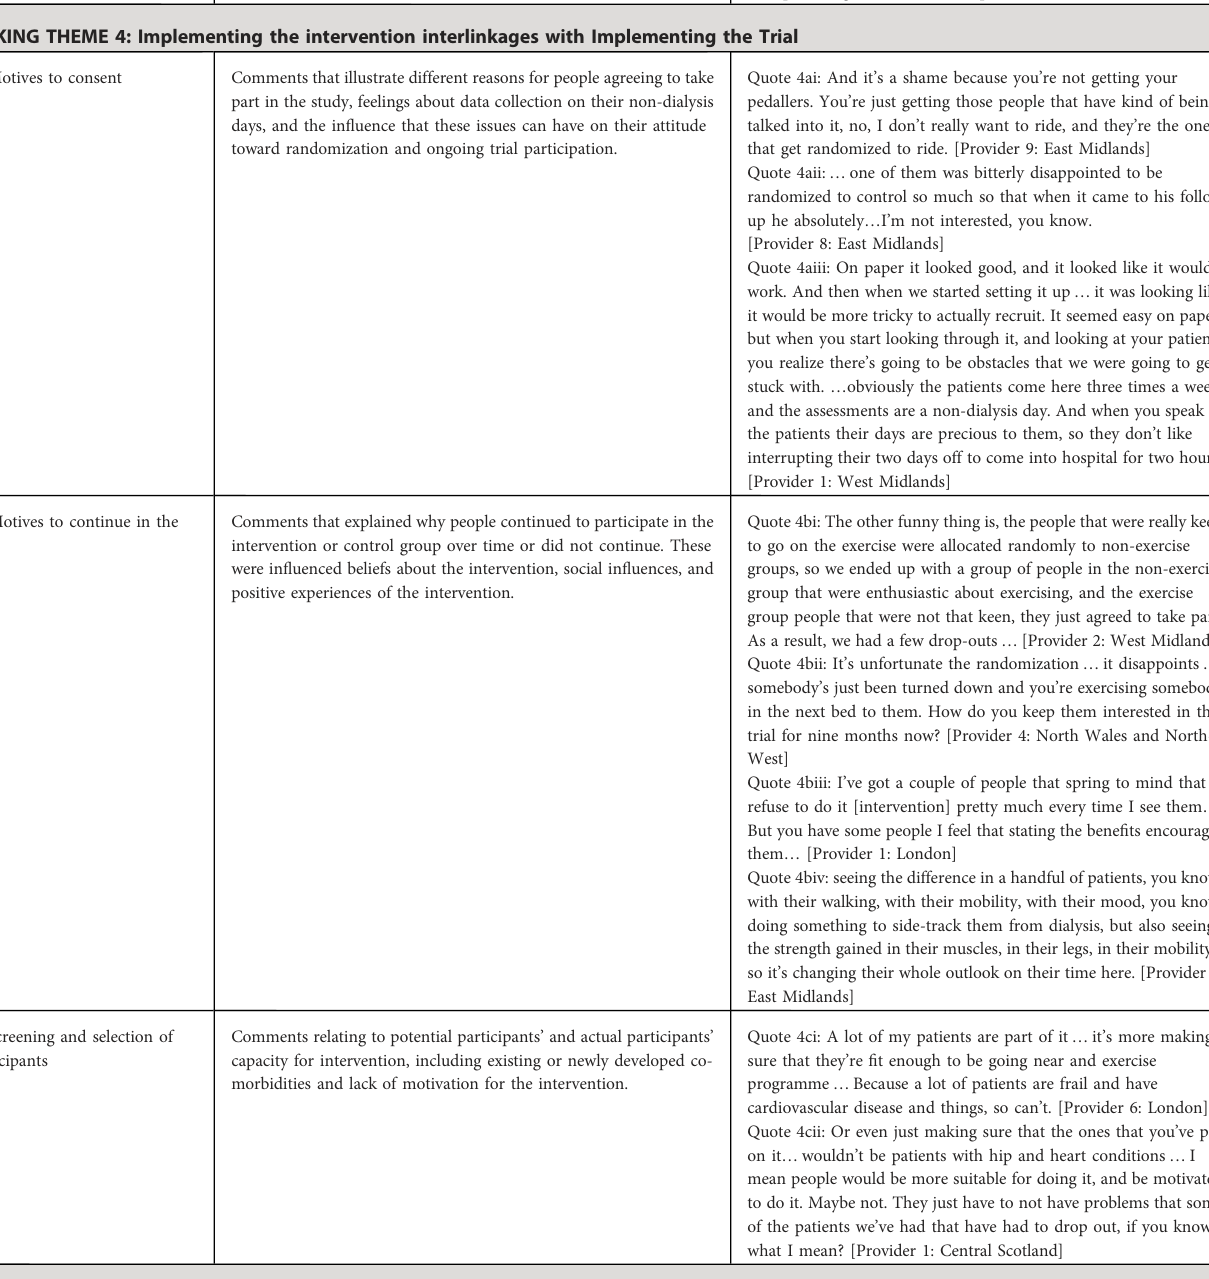
TABLE 2 Summary of overlap between initial themes with de fi nitions and example data. Sub-theme names (grouped by Theme – named in dividing